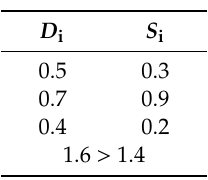
Table 1. Exemplary relationships between D i and S